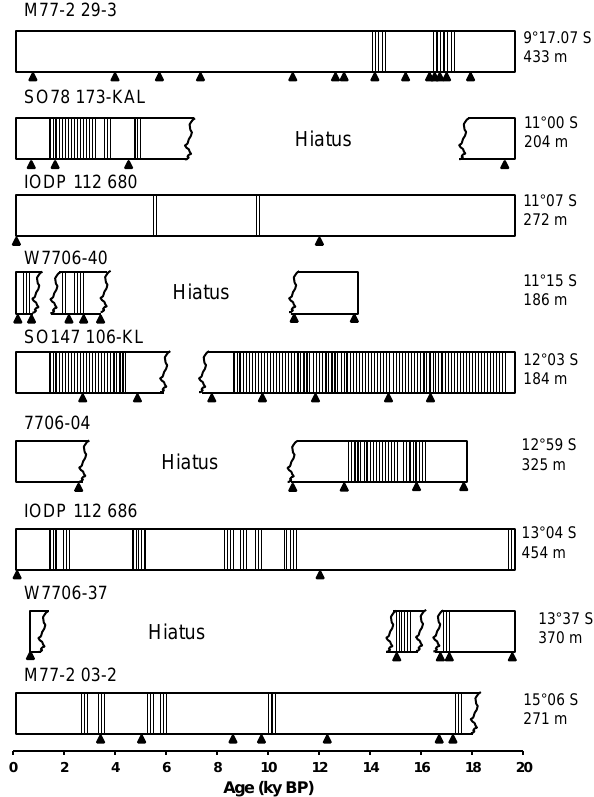
Figure 3. Distribution of laminated intervals in sediment cores from the Peruvian OMZ. Triangles depict age control points. All cores were radiocarbon dated except IODP 112 680 and 686, which have been dated by graphic correlation of the benthic stable oxygen iso- tope curve with the SPECMAP stack (Imbrie et al., 1984; Wefer et al., 1990). Note that laminations were not recorded in sediments deposited between 6 and